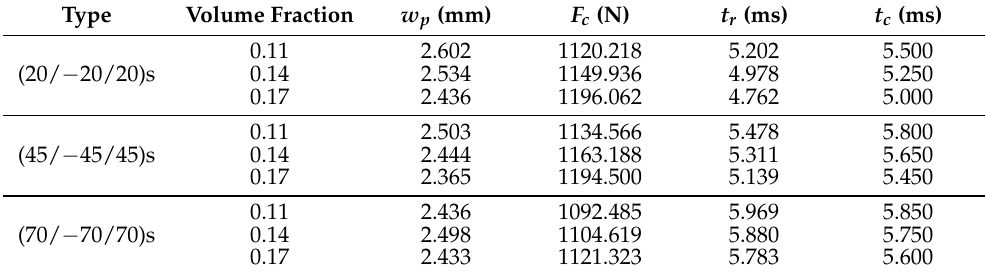
Table 6. Low-velocity impact response of a sandwich structure with various volume fraction of CNTs.